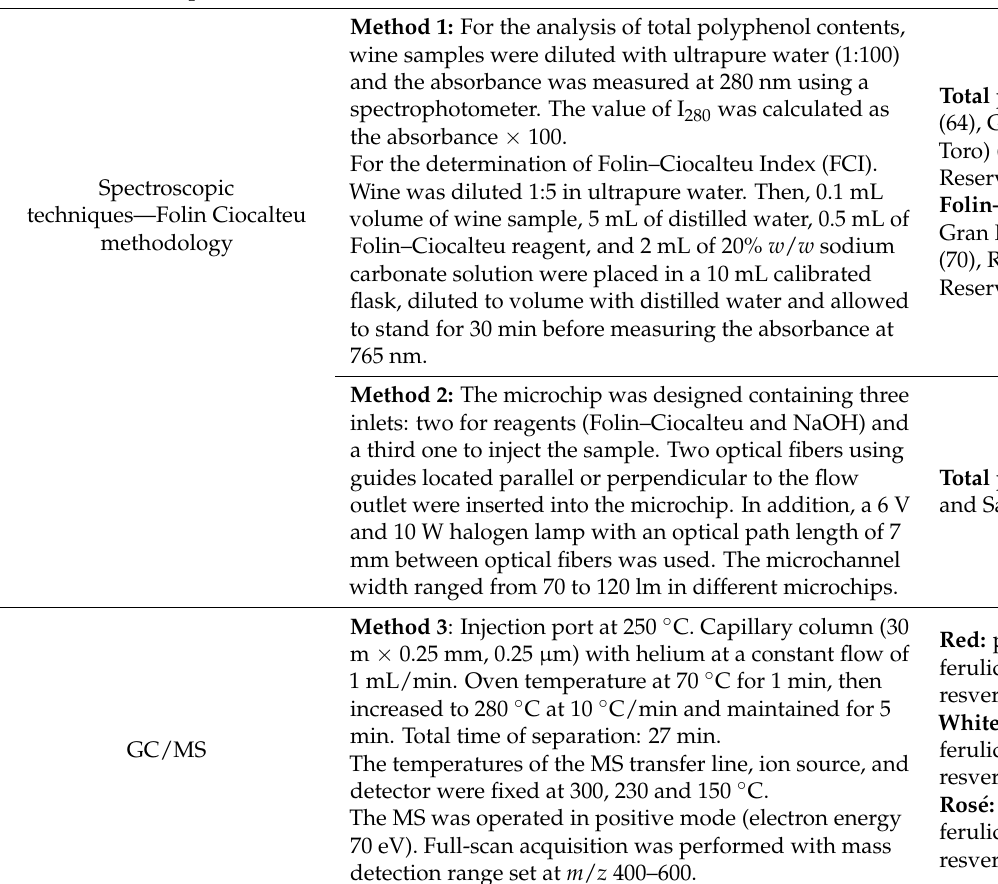
Table 6. Summary of techniques and methods applied for the quantification of phenolic compounds on wine. Technique